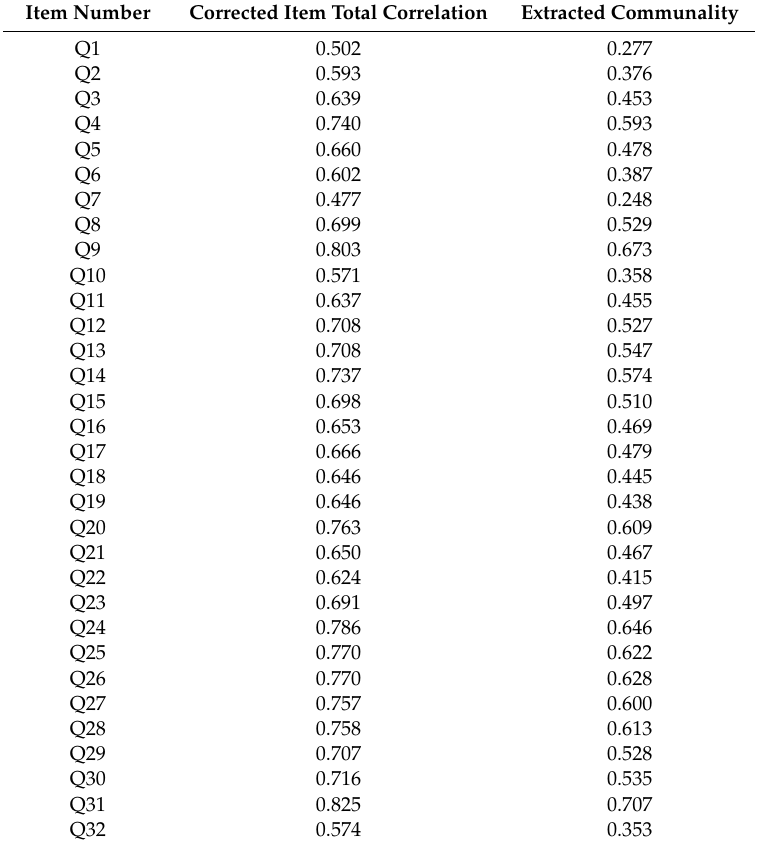
Table 6. Item analysis